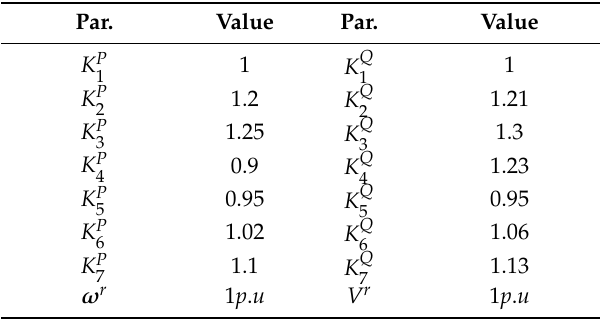
Table 1. The parameters of consensus controller